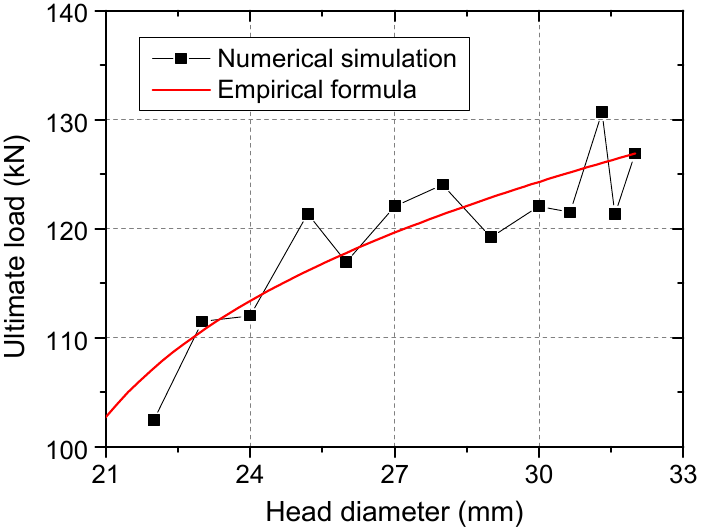
Figure 16. Comparison between calculation results of numerical simulation and empirical for- mula.